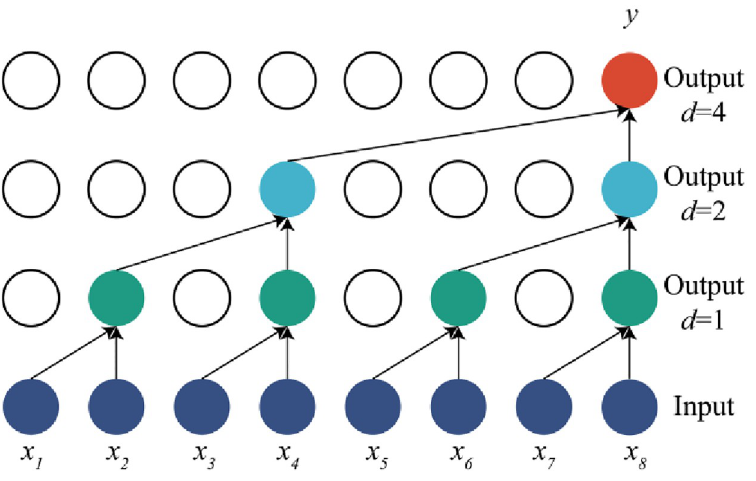
Fig 3. Dilation causal convolution, k = 2, d = [1,2,4], step size is